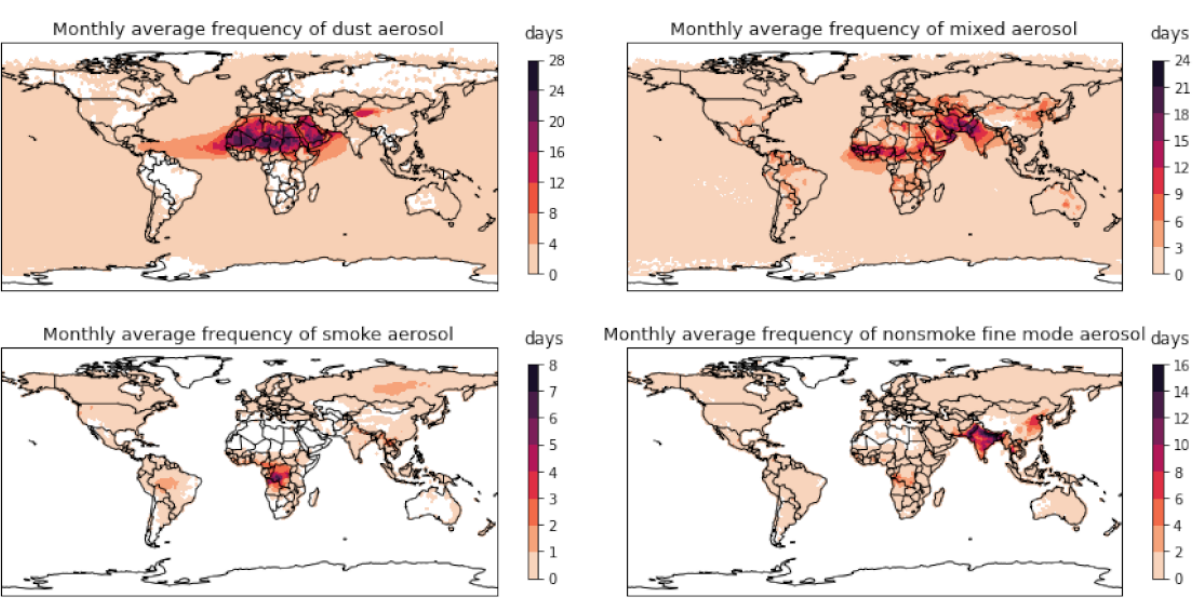
Figure 9. The contour map for four kinds of aerosol categories retrieved from VIIRS Deep Blue Production (the blank implies the absence of corresponding